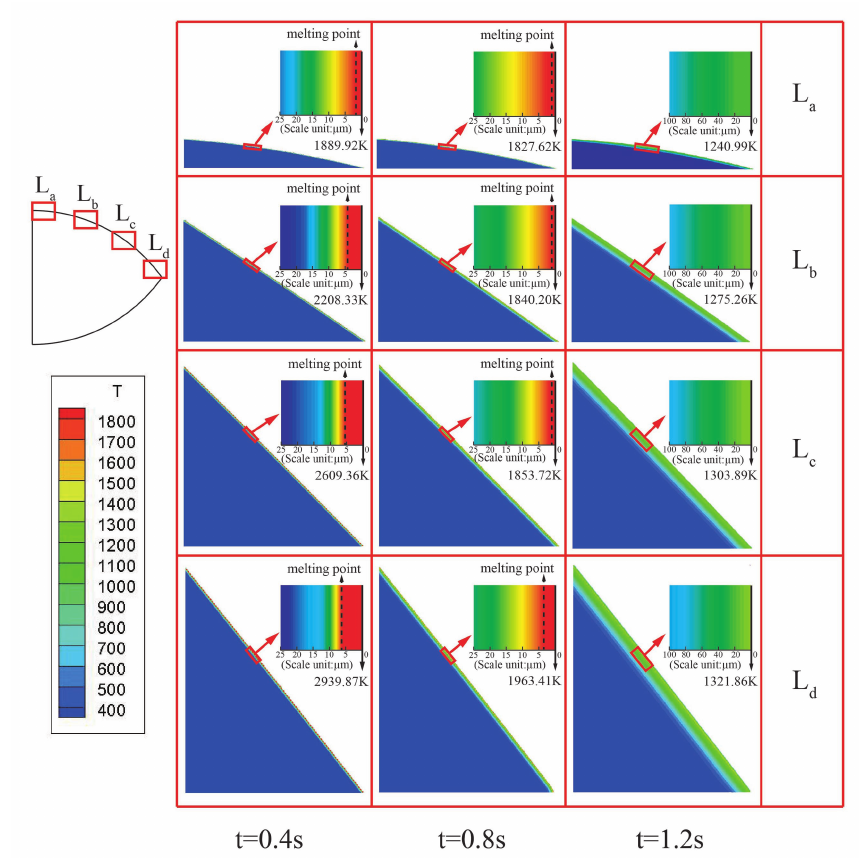
Figure 9. The temperature distribution on projectile surface at different penetrating times. The HAZ thickness at the tip of the nose is obviously larger than that at the tail of the